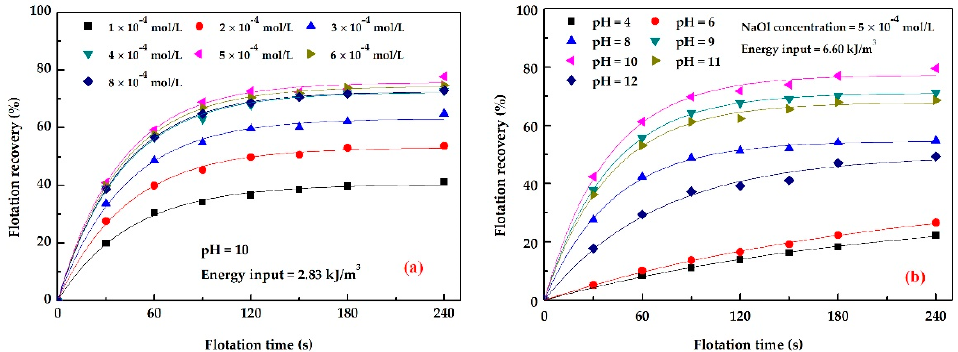
Figure 5. Effect of ( a ) NaOl concentration and ( b ) pulp pH on the flotation performances of diaspore.